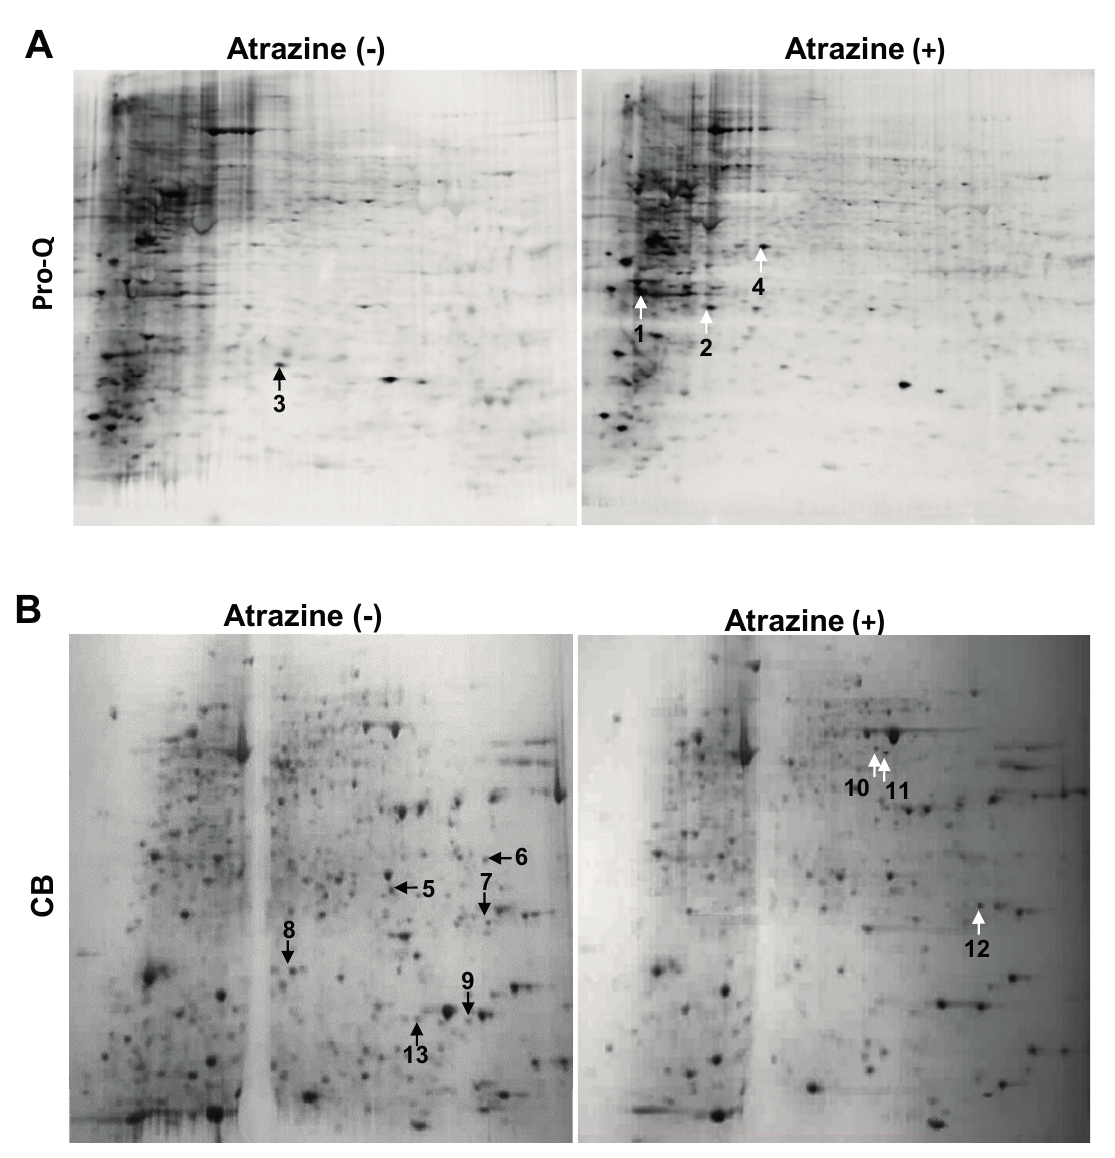
Figure 1. 2D gel identification of differentially expressed phosphoproteins and total proteins in MCF-10A cells treated with or without atrazine. MCF-10A cells were treated with or without 0.1 µg/mL atrazine for 6 h, harvested and lysed. After centrifugation, proteins in the resulting supernatants were analyzed by 2D gel electrophoresis and stained with Pro-Q Diamond Phosphoprotein Gel Stain ( A ), followed by CB staining ( B ). Acquired images were repetitive. The data shown are representative of three separate experiments. Differentially expressed protein spots were labeled with arrows (black: under-expressed spots; white: over-expressed spots) and numbers, which are the same as those in Table